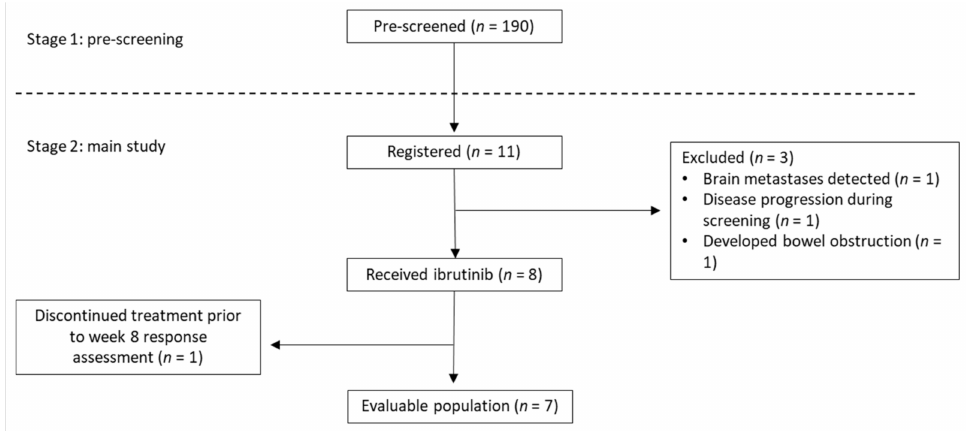
Figure 1. Consort